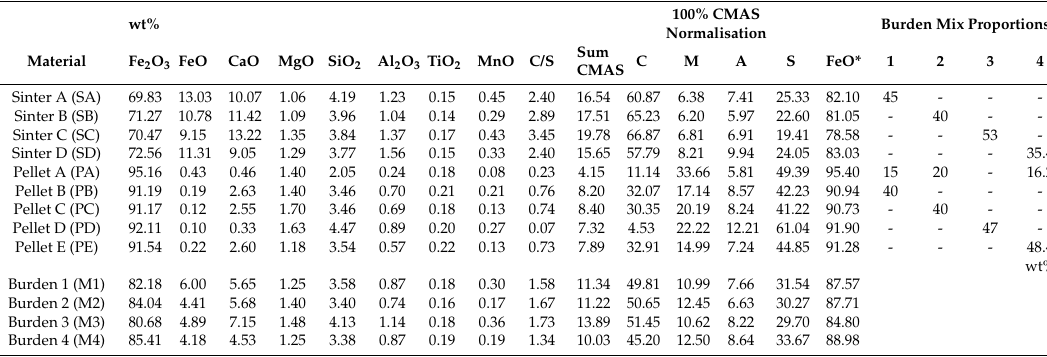
Chemical compositions of individual burden components and bulk burden mixes. Abbreviations: C = CaO; M = MgO; A = Al 2 O 3 ; S = SiO 2 . FeO* = 100FeOtot/[FeOtot + sumCMAS], where FeOtot = total Fe expressed as FeO